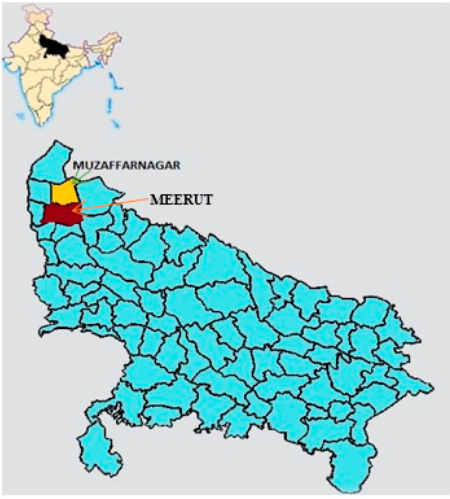
Figure 1. A map of Uttar Pradesh State indicating study sites.